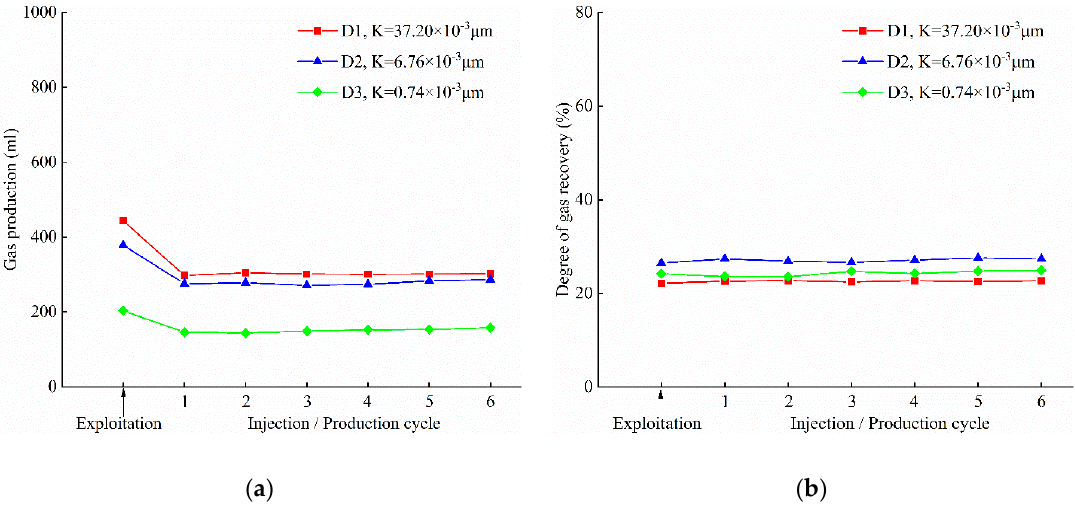
Figure 14. Variation curve of gas production ( a ) and degree of gas recovery ( b ) in the gas-water transition zone.